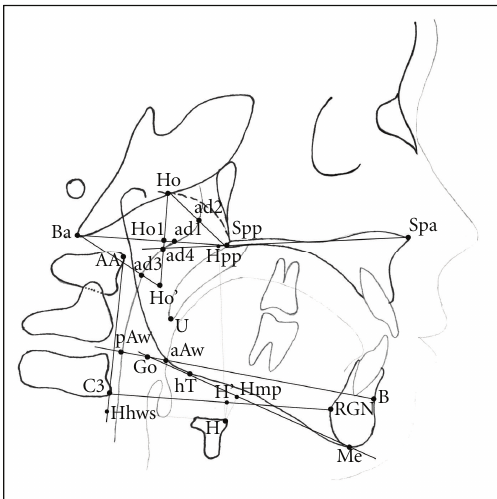
Figure 2: Cephalometric landmarks of the naso- and oropharyn- geal area. (Spa: anterior nasal spine, Spp: posterior nasal spine, Ho: hormion, Ba: basion, AA: anterior arcus atlantis (first cervical spine), C3: anterior third cercival spine (C3), H: hyoid, Me: menton, RGN: retrognathia, B: submentale/B-point, aAw: anterior airway, pAw: posterior airway, ad1–4: adenoids